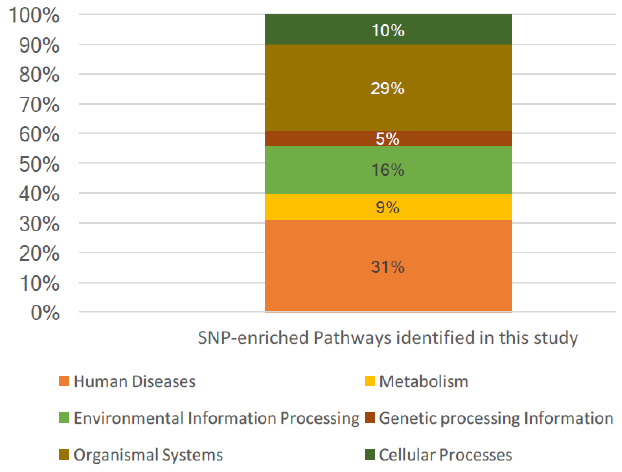
Figure 3. The distribution of the types of SNP-enriched pathways identified in this study and a comparison to the pathway distribution of the Kyoto Encyclopedia of Genes and Genomes (KEGG).